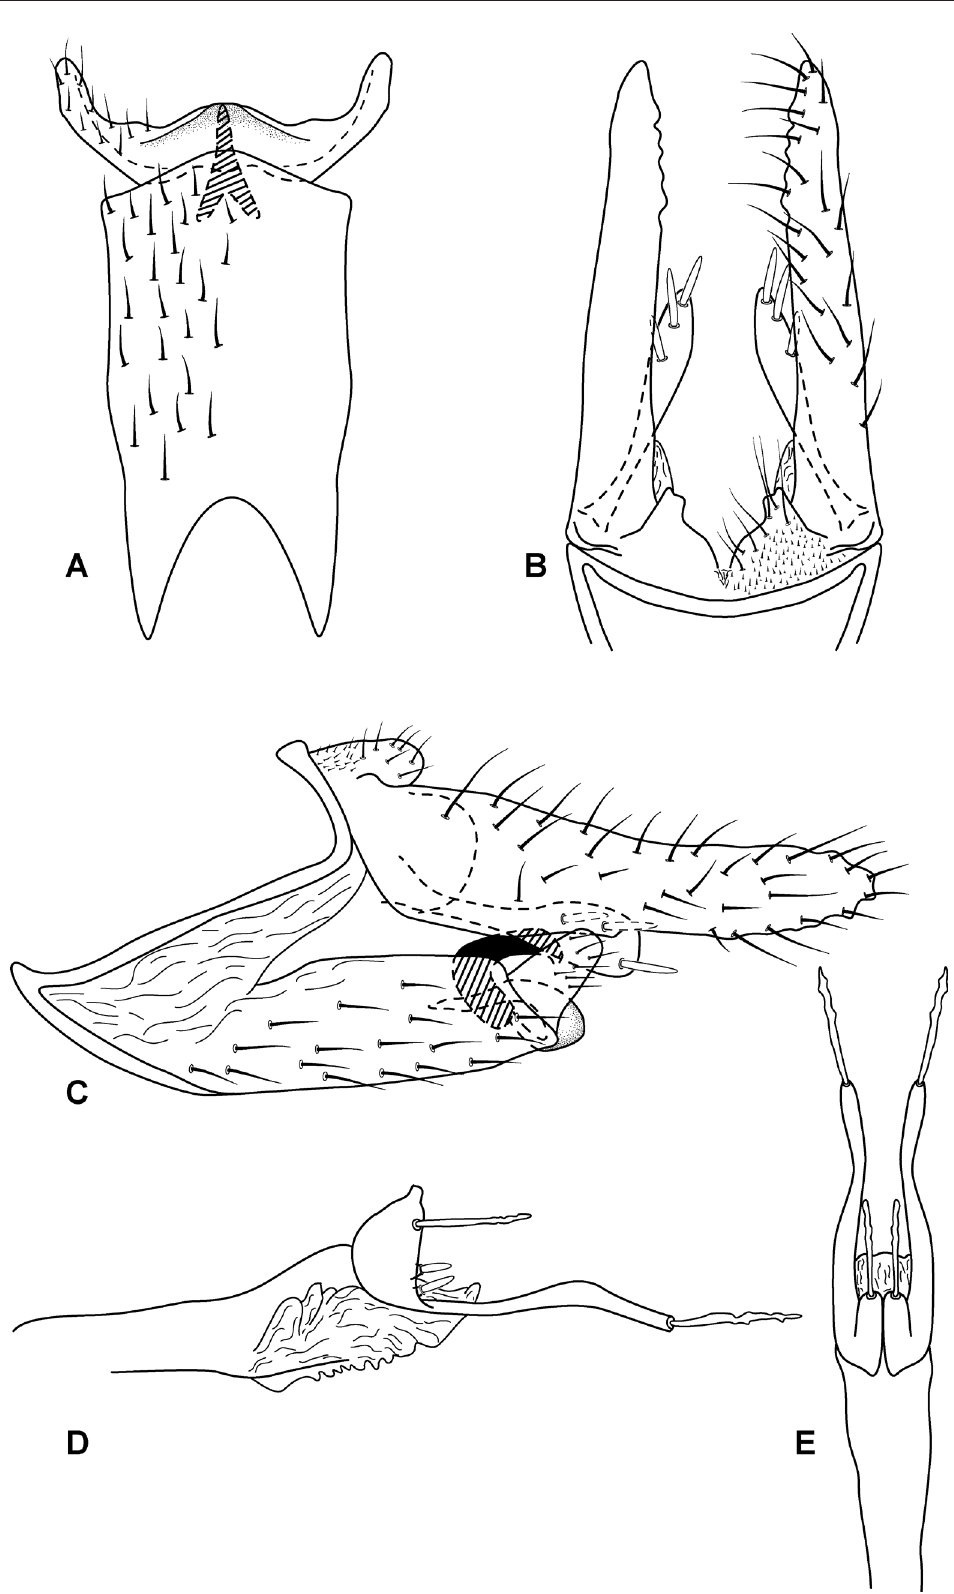
Fig. 10. Austrotinodes lenti sp. nov., male genitalia. A . Ventral view. B . Dorsal view. C . Left lateral view. D . Phallic apparatus, left lateral view. E . Phallic apparatus, dorsal